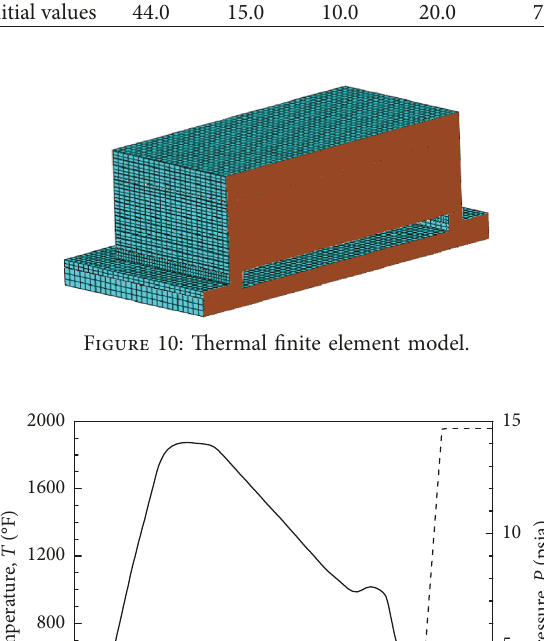
Figure 12: Transient heat transfer analysis results at nodes A to D and referenced